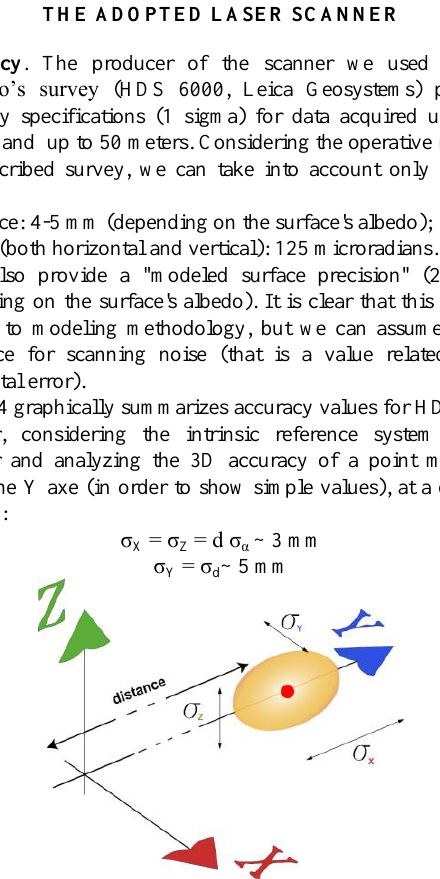
Figure 7. Beam diameter, increasing with range. In orange, the operative range for the Sangallo’s house